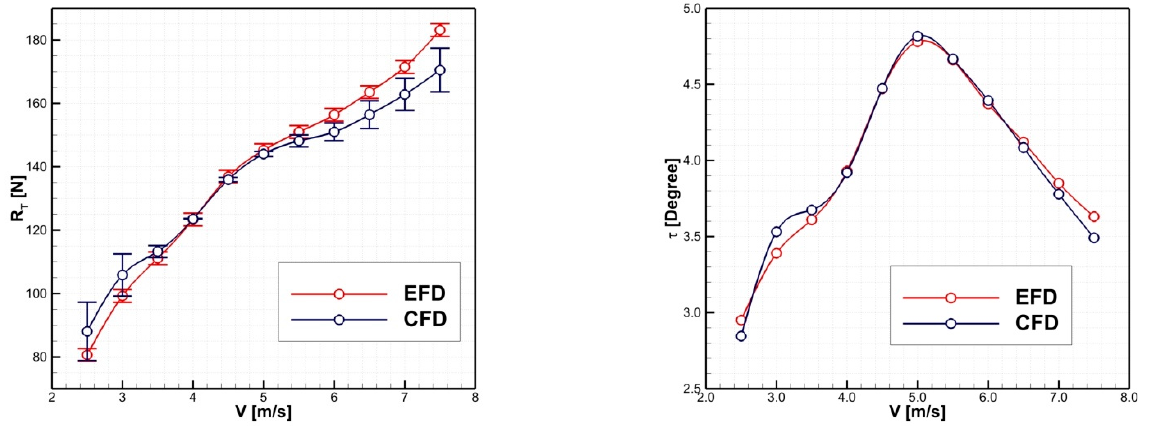
Figure 5. Total resistance and dynamic trim computed vs. experimental data reconstructed from Ref. [13].